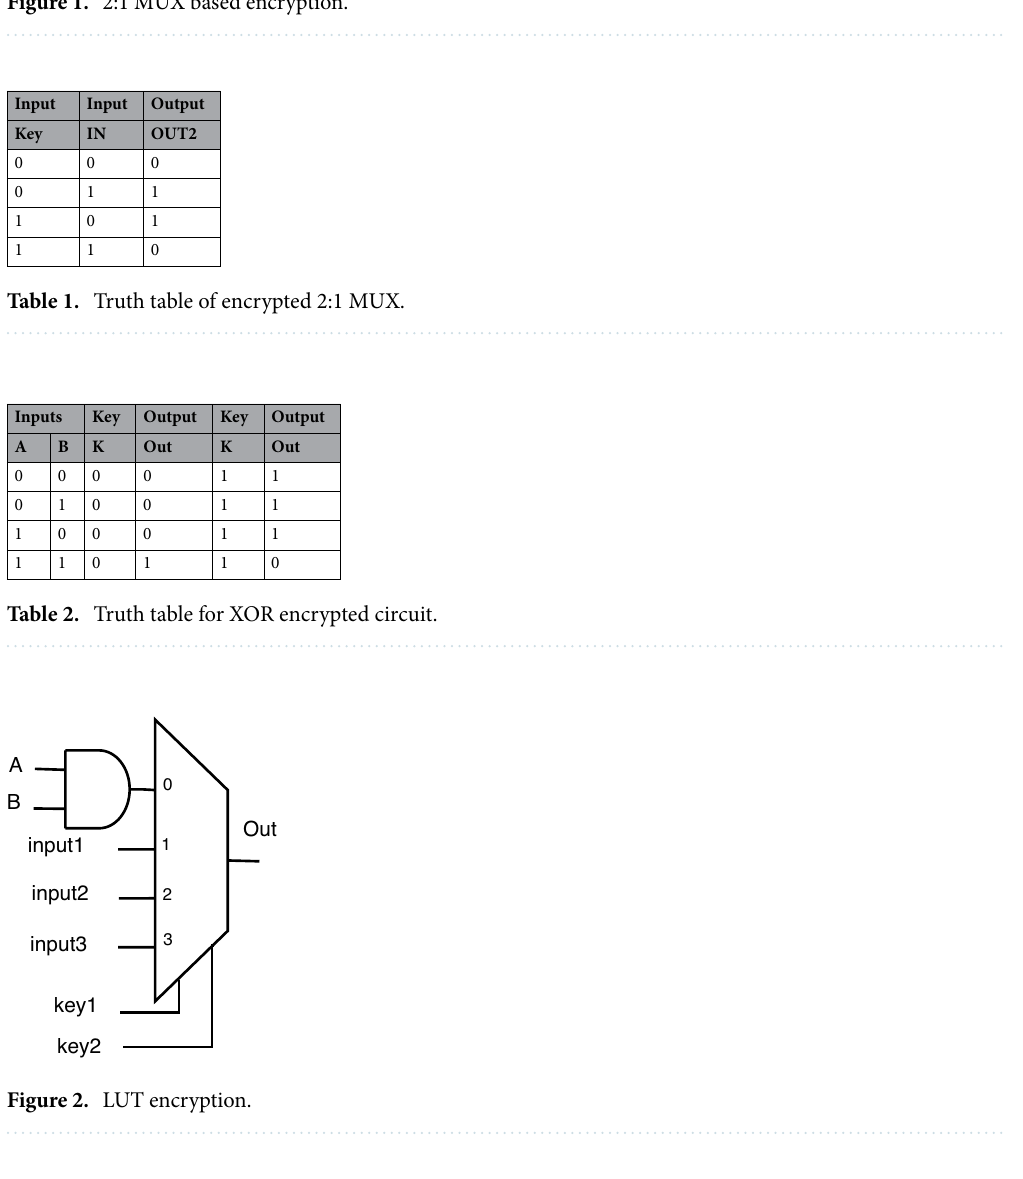
Figure 1. 2:1 MUX based encryption.